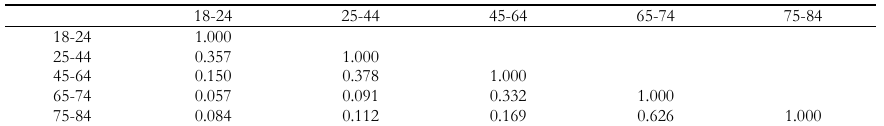
Distances matrix of correlation coefficients (range: 0 = max distance (dissimilarity), 1 = max similarity between pairs of